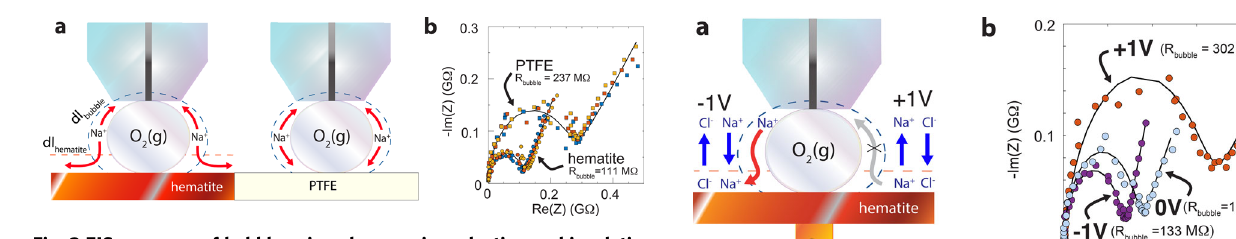
explain our fi ndings based on the attraction and mobility of ions in the EDL. A negative potential draws countercations from the bubble to the supporting solid, explaining the lower resistivity of the bubble. In contrast, a positive potential inhibits countercation transport to